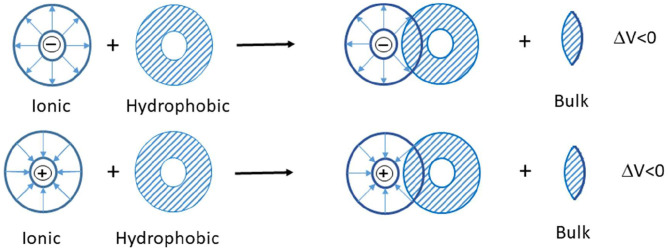
The interaction of two co-spheres (Lin et al., 2006).